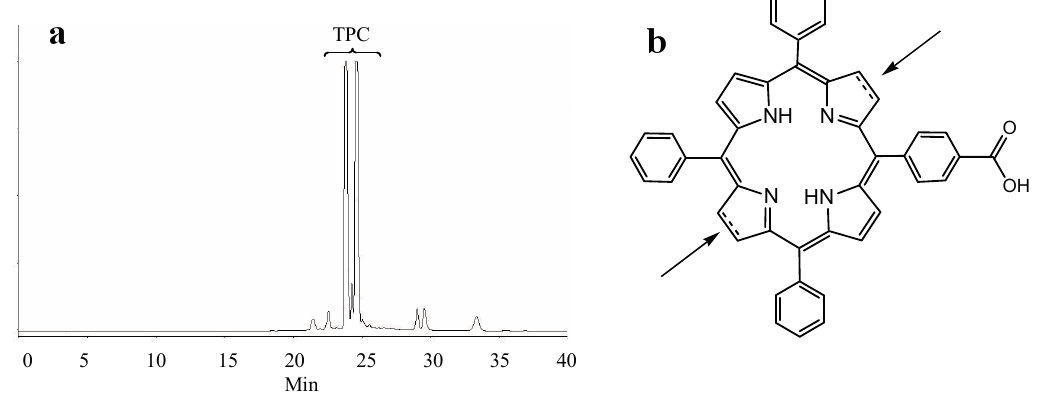
Figure 2. ( a ) HPLC chromatogram of crude TPC at 415 nm; ( b ) The two possible positions of the reduced bond.